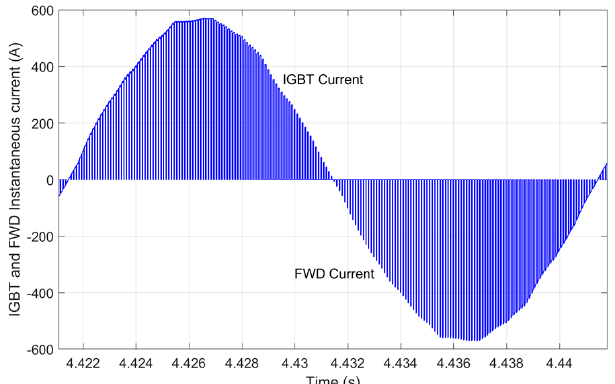
Figure 7. Instantaneous current of an IGBT module in a direct current/alternating current (DC/AC) application.